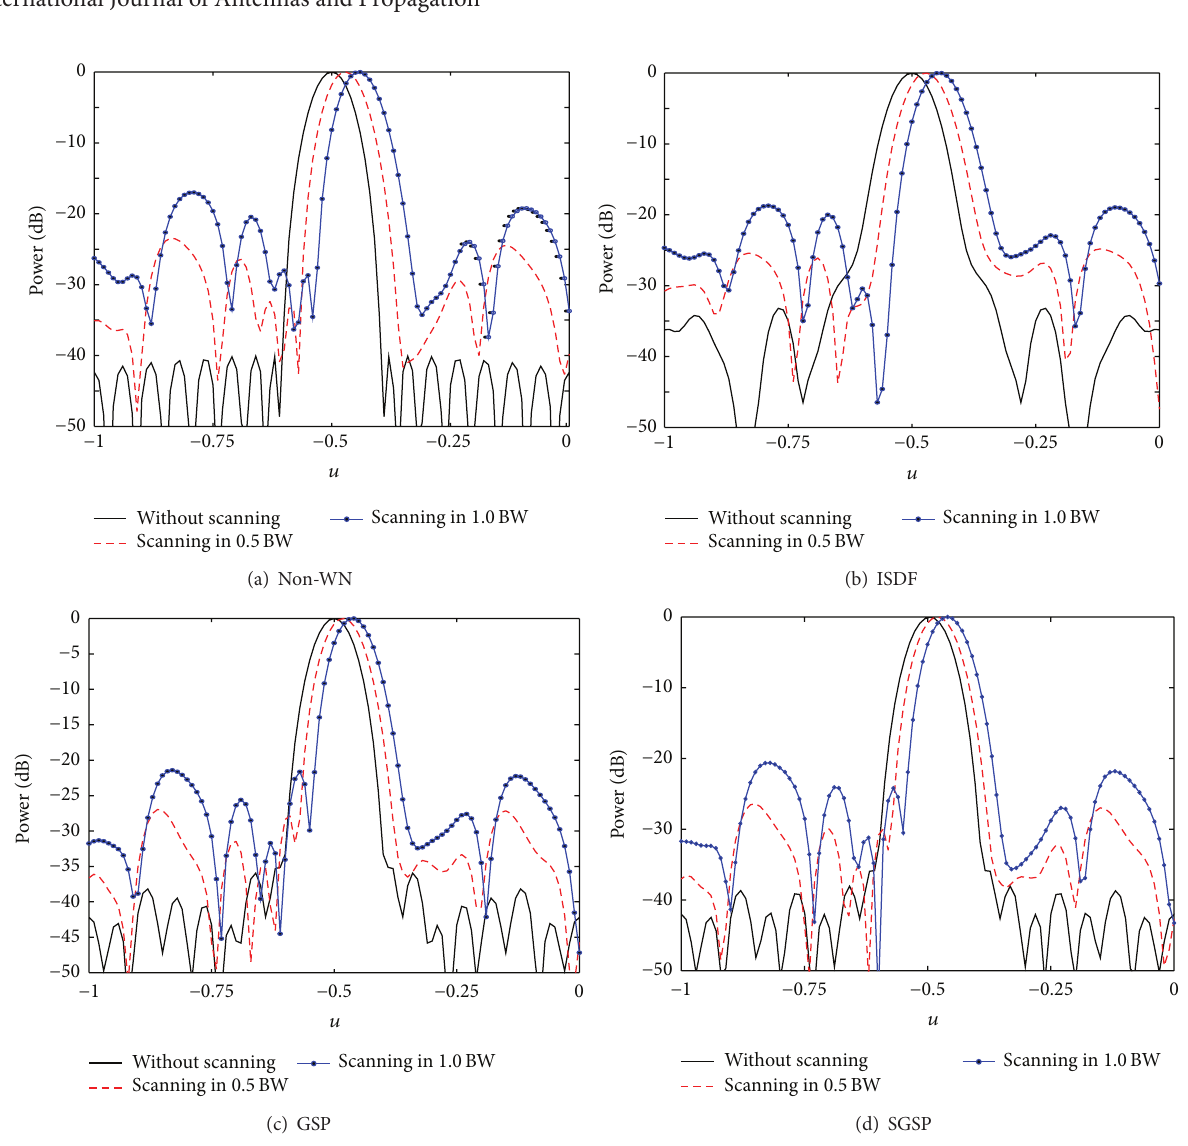
Figure 4: Array patterns with SBS obtained by different methods (azimuth